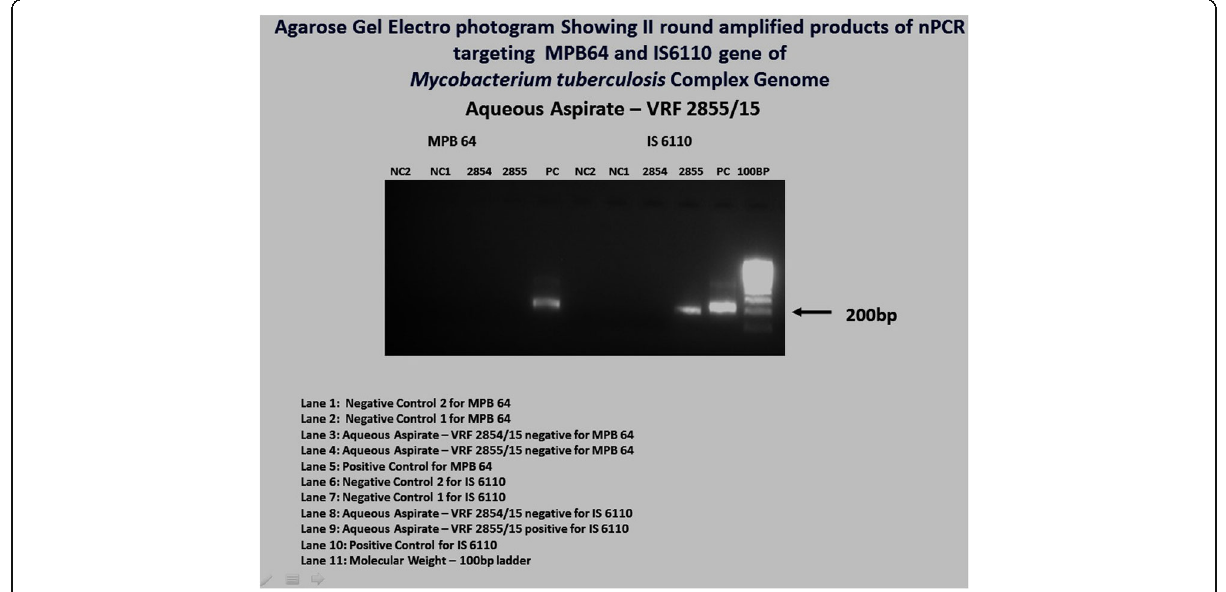
Fig. 1 Agarose gel electophotogram showing the detection of Mycobacterium tuberculosis complex